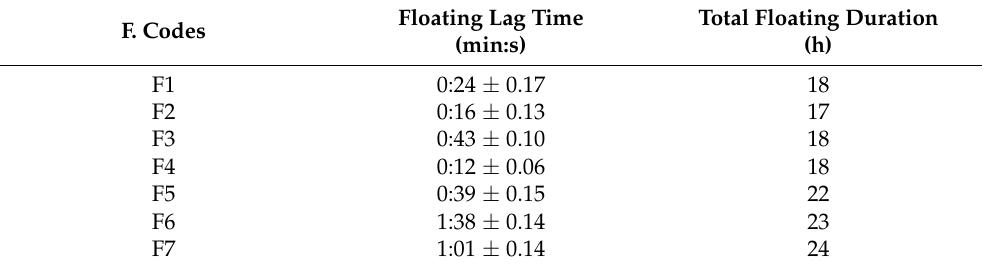
Table 3. The floating characteristics of the formulated tablets.